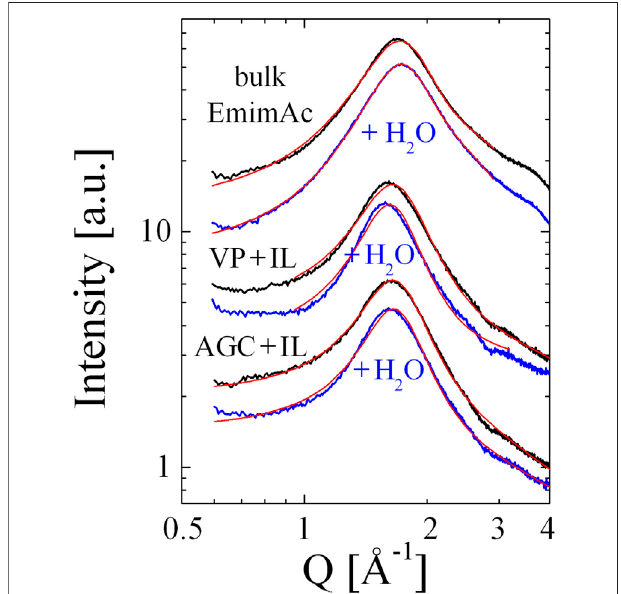
FIGURE3| The XRDscattering intensitiesasafunctionofthe scattering vector, Q. The anhydrous IL (black) and the IL-water mixture (blue) in bulk and in con fi nement (VP and AGC glass matrices). The red lines represent the non- linear least-squares fi ts of the data to the appropriate